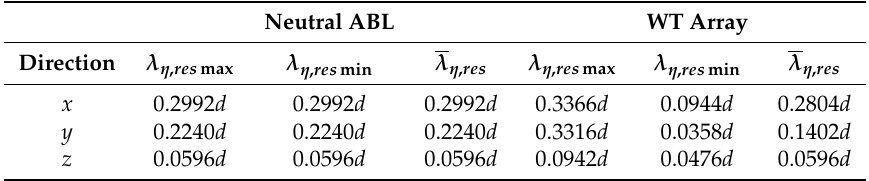
Table 2. Maximum, minimum and average wavelengths captured, for the ABL and the wind turbine array domain. d is the turbine rotor